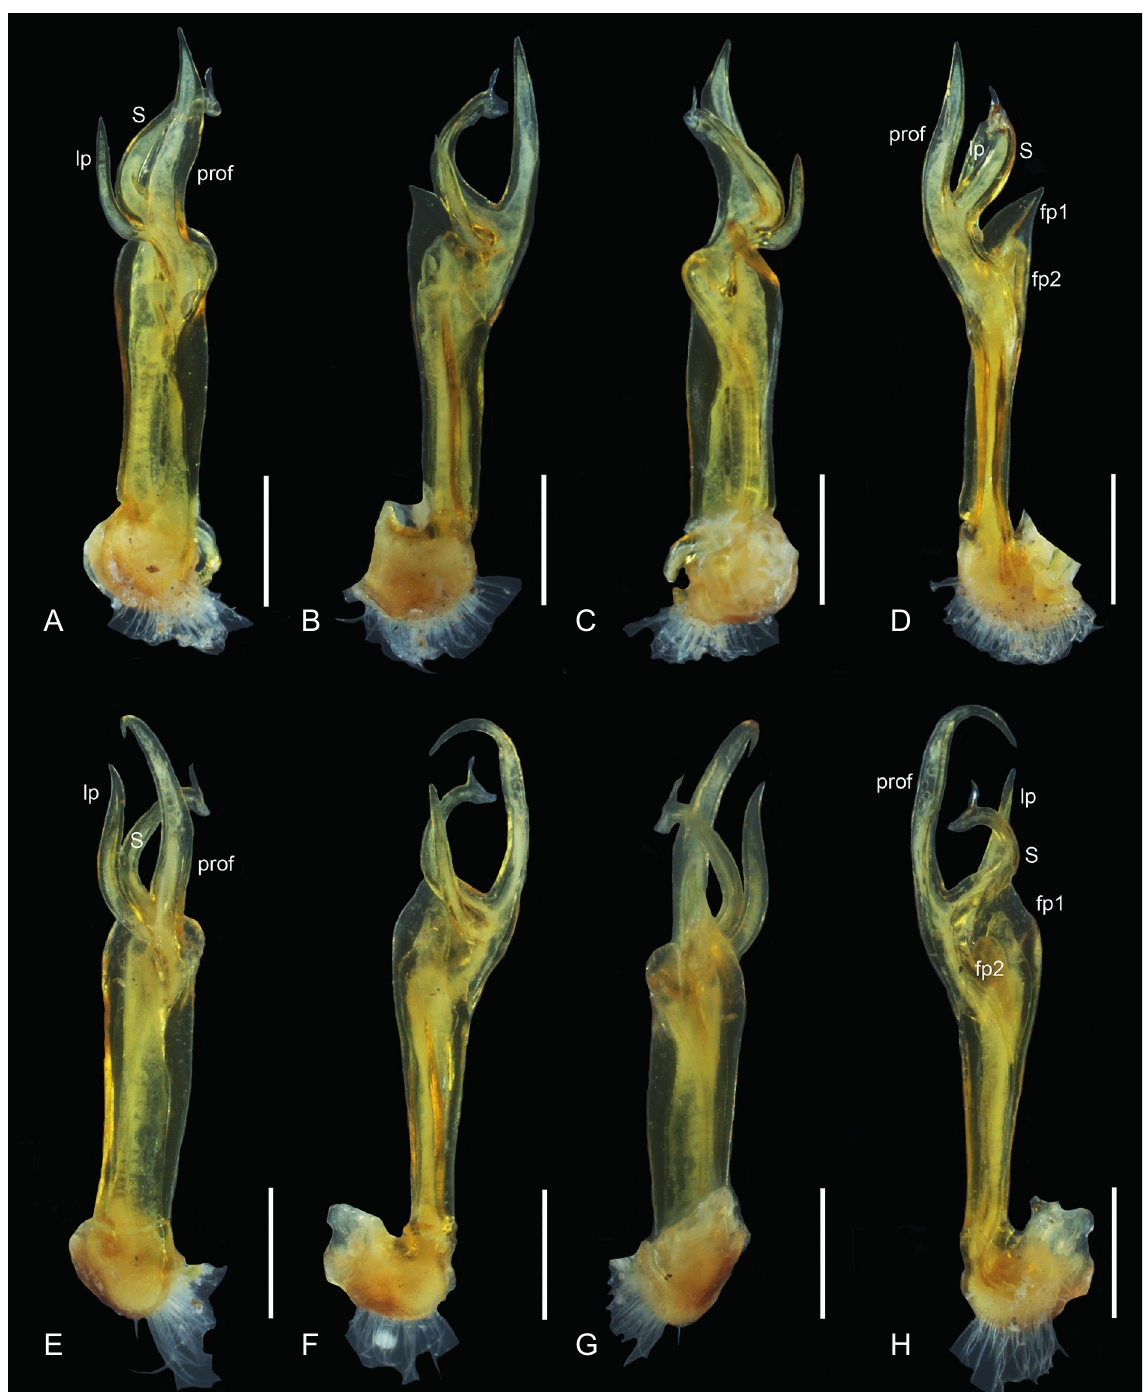
Fig. 9. Pogonosternum nigrovirgatum (Carl, 1902), ♂, right gonopod. A–D . AMS KS96017 Ferntree Gully. E–H . NMV K-10248 from Sandringham and Brighton. A, E . Posterior view. B, F . Lateral view. C, G . Anterior view. D, H . Mesal view. Scale bars: 0.5